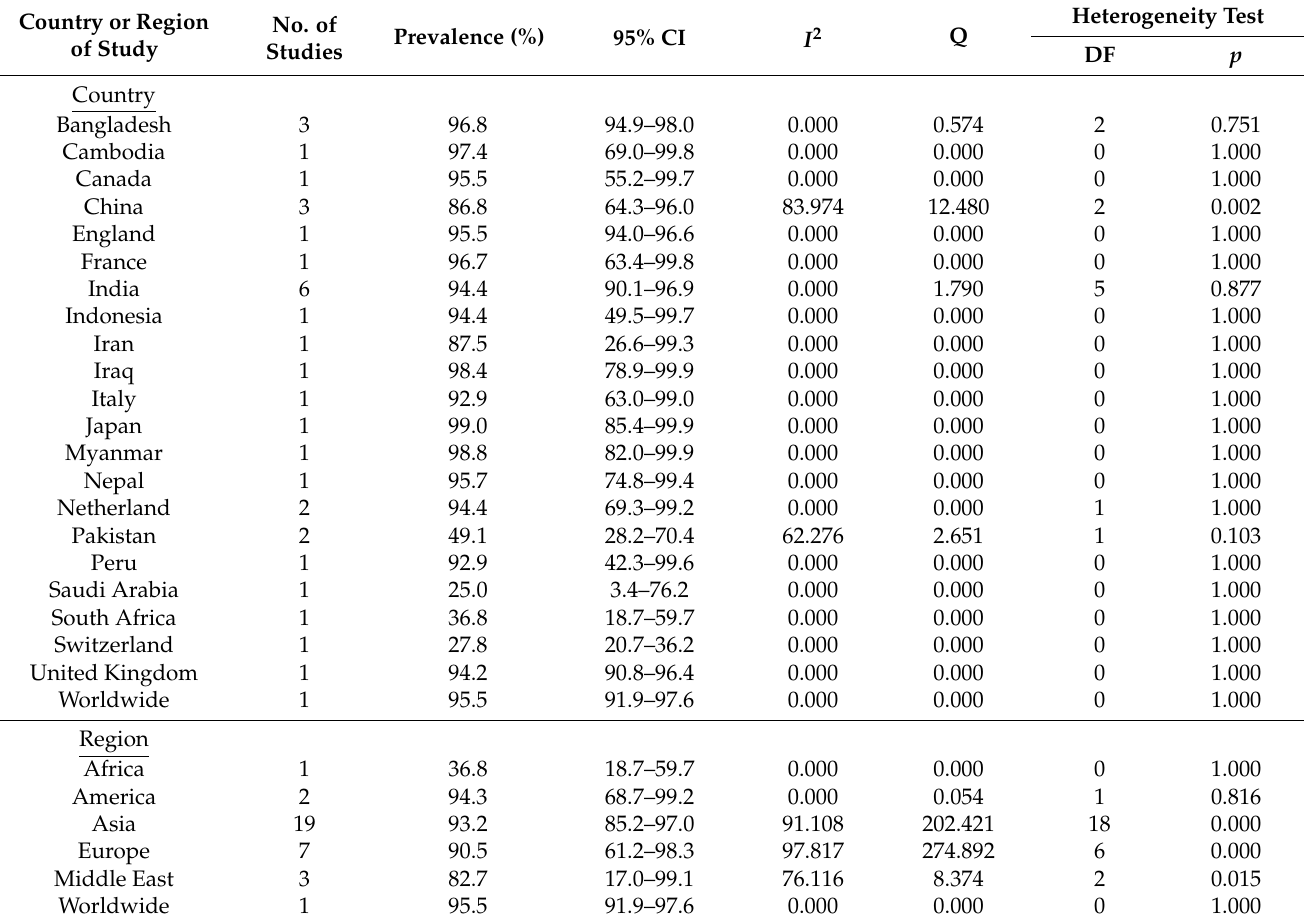
Table 3. Sub-group analysis of prevalence of gyrA gene in S. Typhi according to countries and